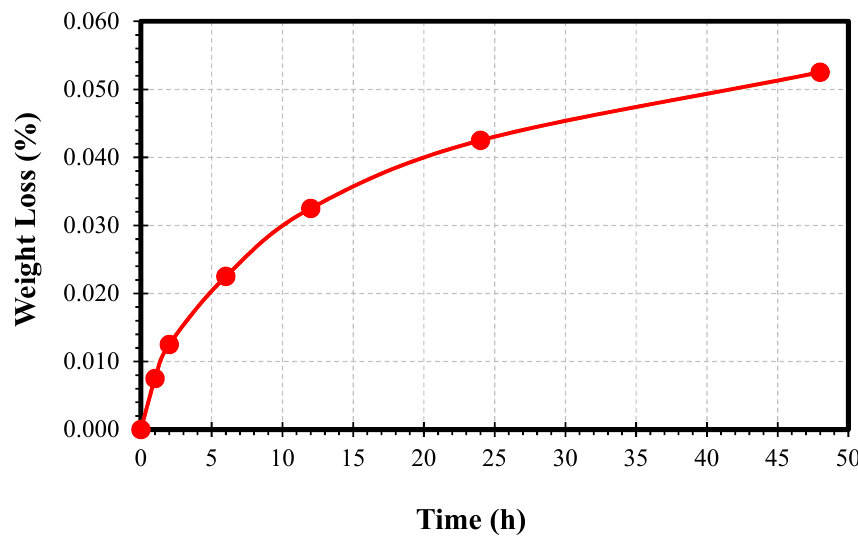
Figure 4. The graph of weight loss in percentage as a function of time in hours.